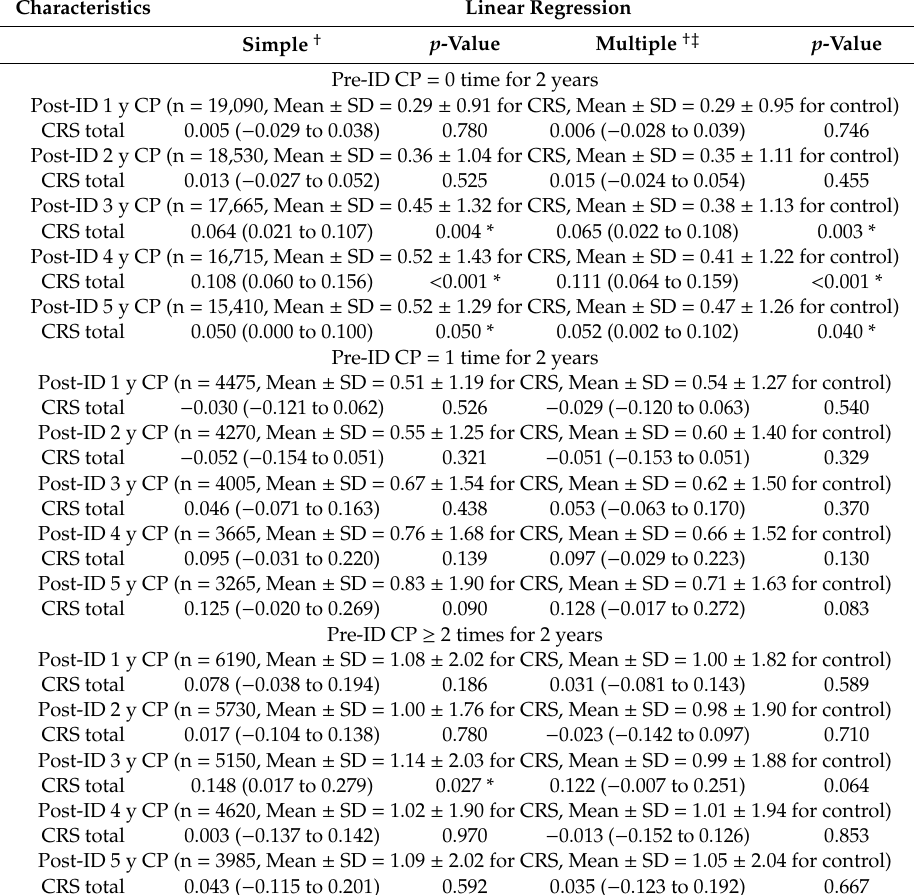
Table 4. Subgroup analyses of simple and multiple linear regression model (estimated value [95% confidence interval]) for post index date of CP (post-ID CP) periods in CRS with / without nasal polyp and control groups according to pre index date of CP (pre-ID CP) for 2 years.